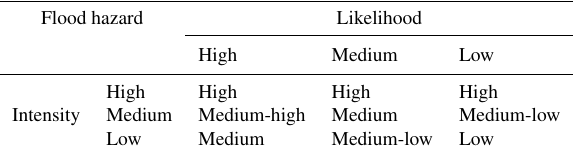
Table 3. Flood hazard classification based on flood intensity (Ta- ble 2) and the semiquantitative system of Raetzo et al.